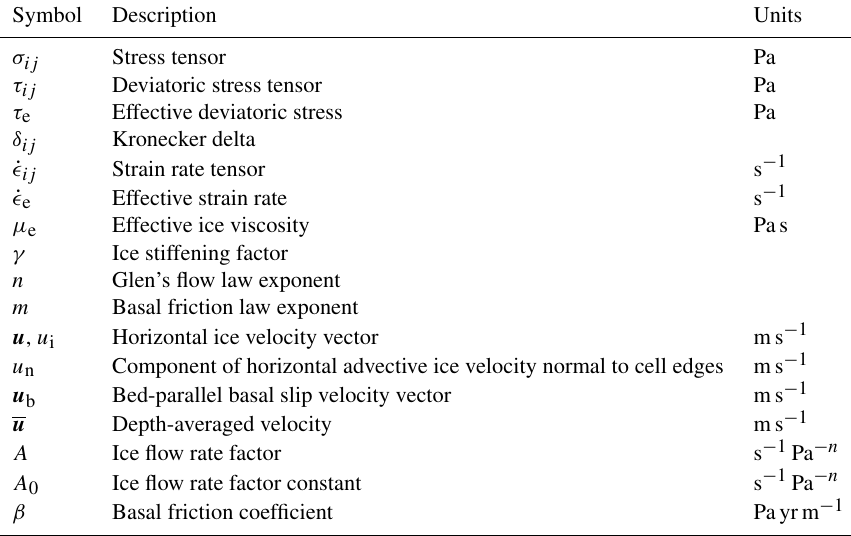
Table A3. Ice dynamics variables and parameters.